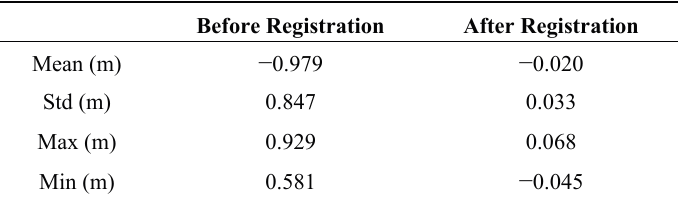
Table. 5. The statistic of the check planes.